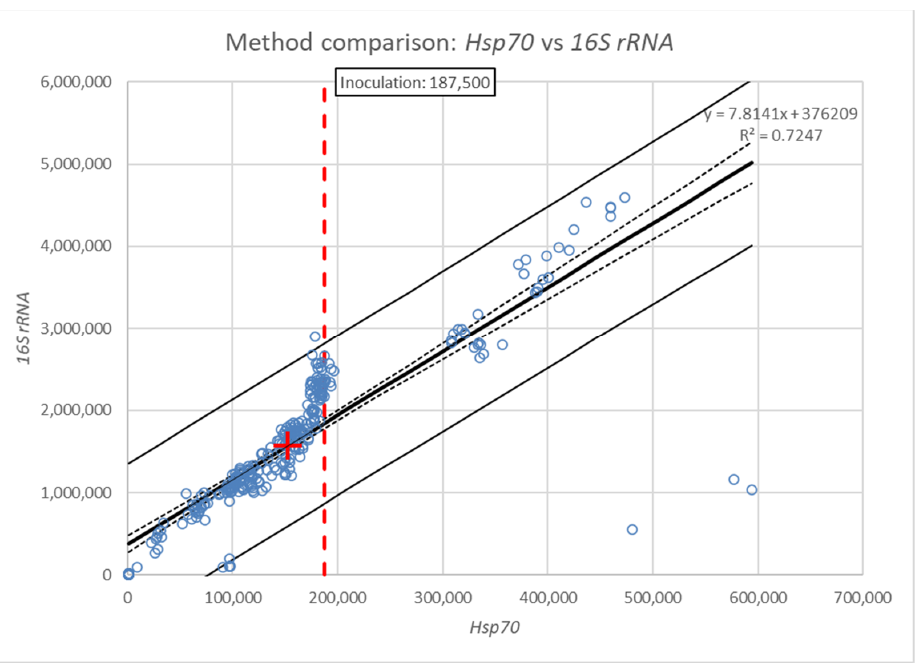
Figure 2. Linear regression analysis between the abundance measured with 16S rRNA (dependent variable) and with Hsp70 (independent variable) methods. Legend-blue circles: experimental data, red cross: average values, red dashed line: inoculated dose, thick solid line: regression line, dashed thin lines: confidence interval of regression, solid thin lines: prediction interval.